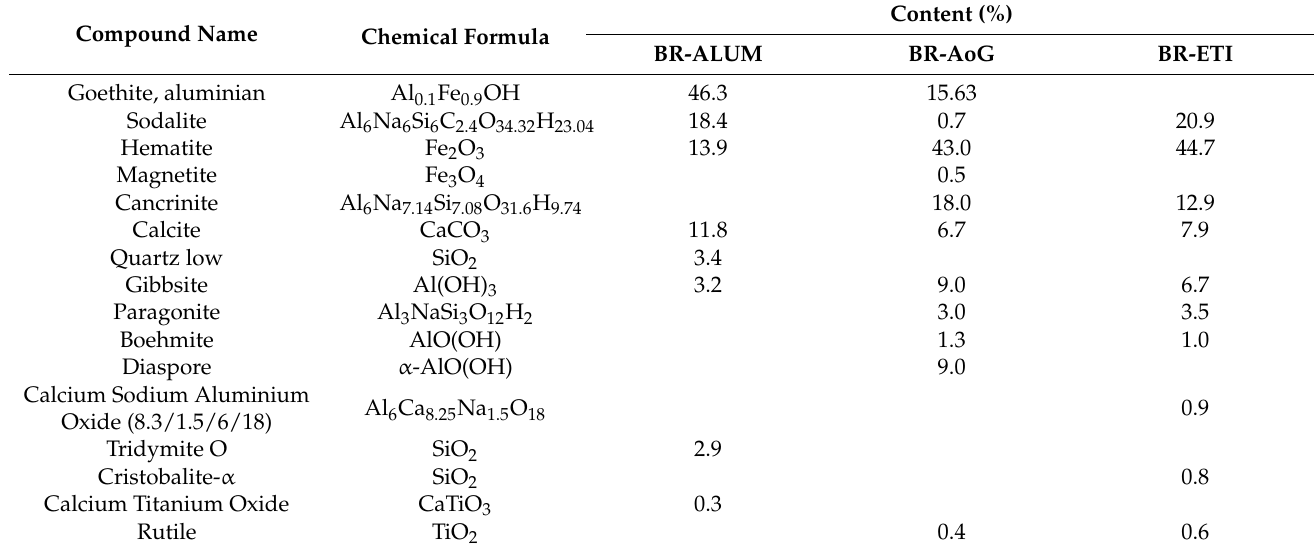
Table 3. Structures on BR of ALUM, AoG, and ETI and their distribution according to Rietveld analysis method.